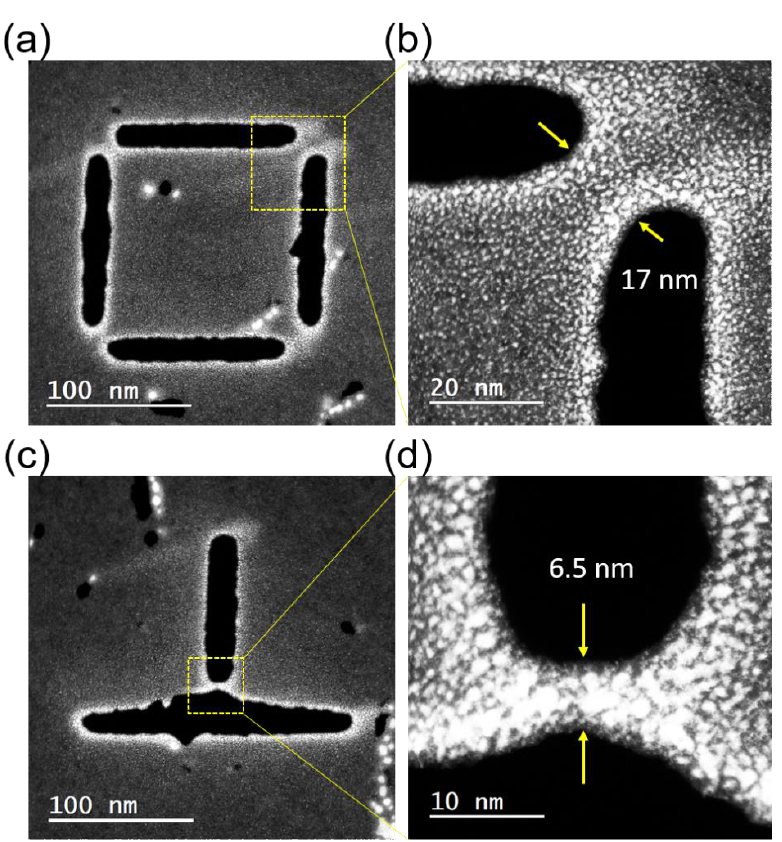
Figure 6 . STEM images for preannealed graphene samples, after laser-assisted He + milling. Images of a corner cut and a vertical cut are shown in ( a and b ) and ( c and d ), respectively. Carbon redeposition is clearly observed near the milled region.